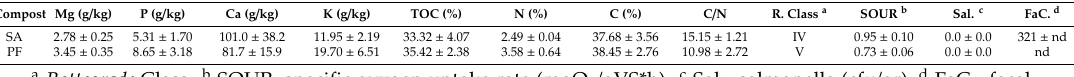
Table 6. Nutrient elements content, C / N ratio, and pathogen indicators in composts from the UDC. Compost Mg(g /